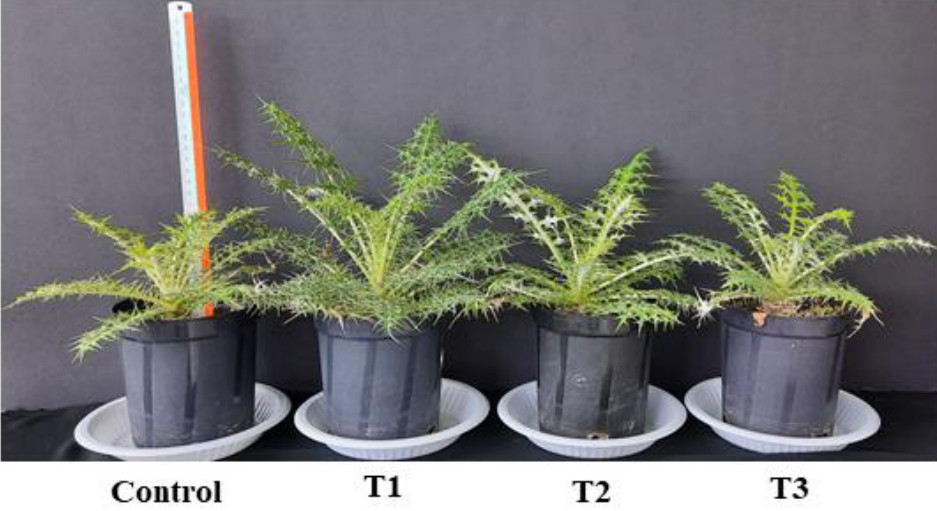
Figure 4. Effect of ZnO-NPs on morphological traits of E. macrochaetus . ZnO-NP treatments: control (0 mg/L); T1 (10 mg/L); T2 (20 mg/L) and T3 (40 mg/L) . (0 mg/L); T1 (10 mg/L); T2 (20 mg/L) and T3 (40